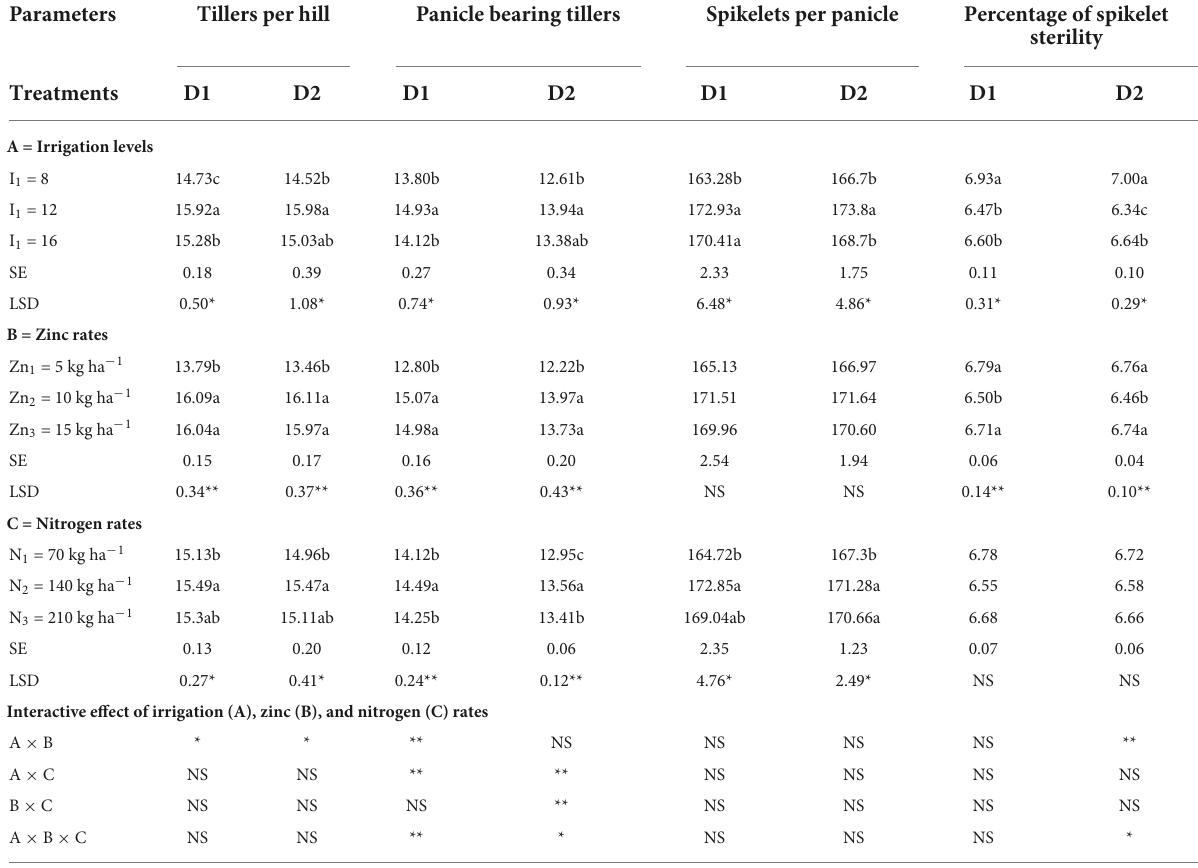
TABLE 2 Impact of zinc and nitrogen rates on number of tillers per hill, panicle bearing tillers, spikelets per panicle, and percentage of spikelet sterility of rice cultivated under three irrigation levels at Sheikhupura (D1) and Sargodha (D2) districts of Pakistan. Parameters Tillers per hill Panicle bearing tillers Spikelets per panicle Percentage of spikelet